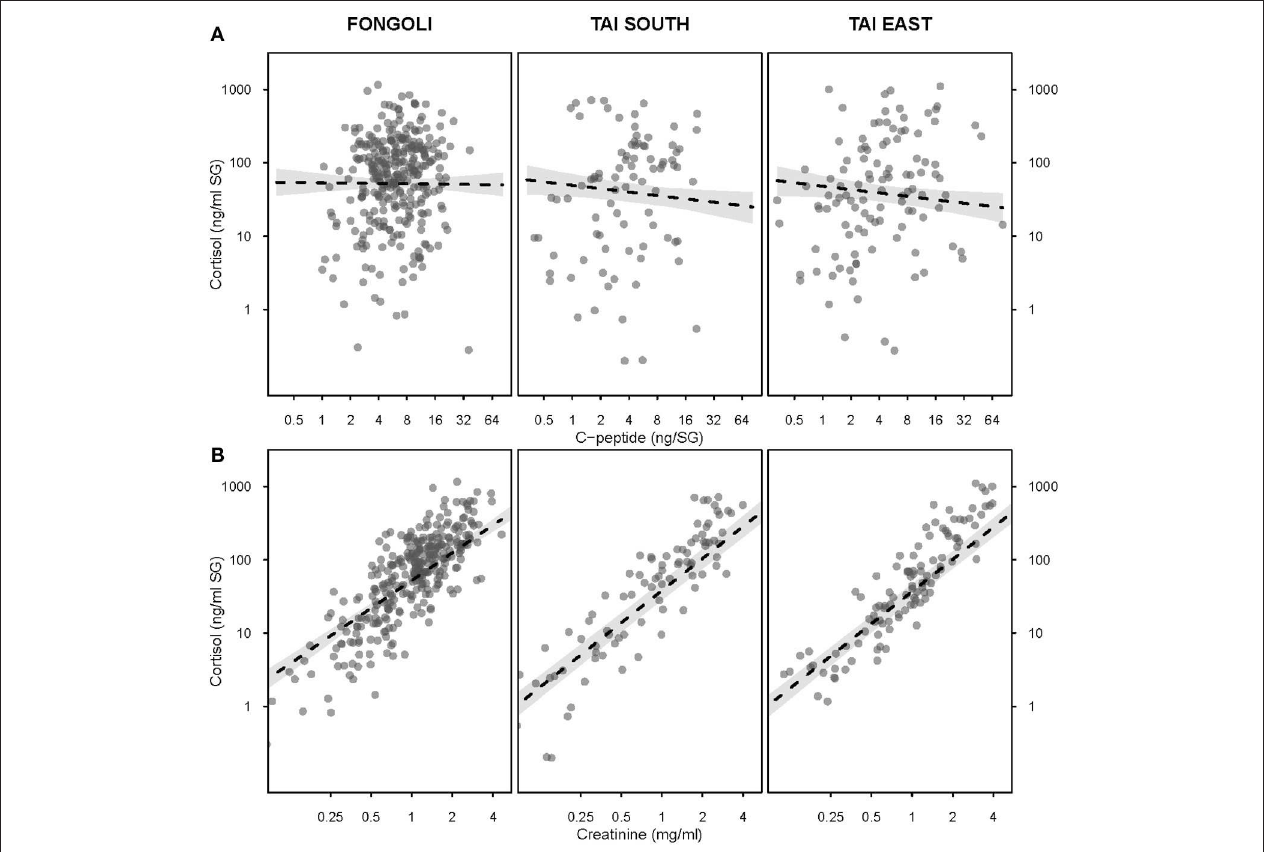
FIGURE 4 | Effects of urinary c-peptide (A) and creatinine levels (B) on urinary cortisol concentration in three chimpanzee communities. All axes are displayed on a logarithmic scale; 95% confidence intervals are displayed in